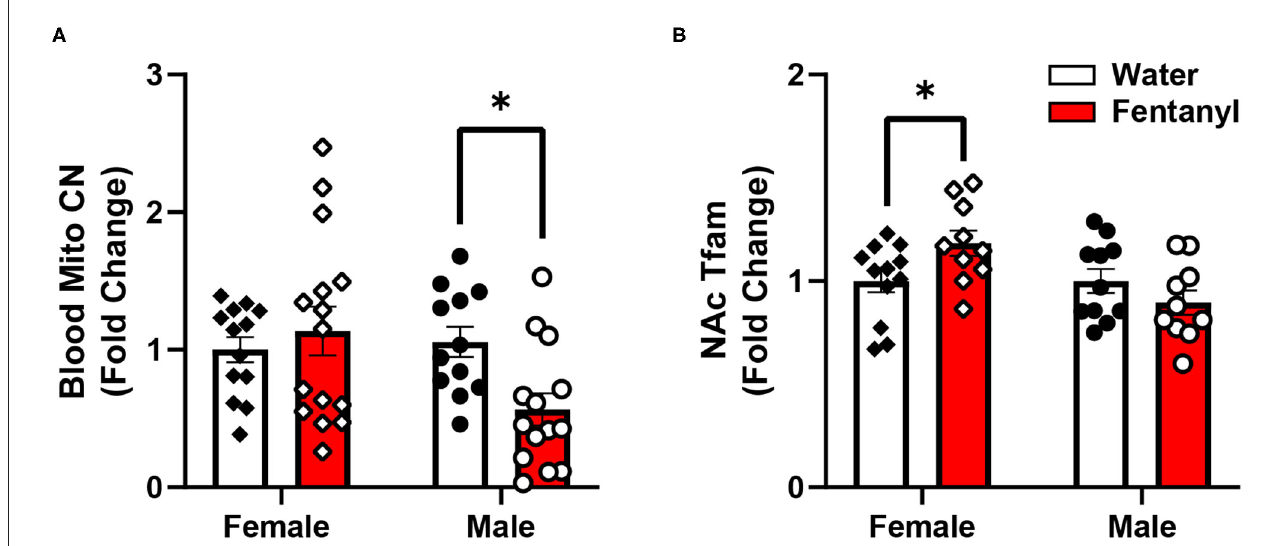
FIGURE 1 | Mitochondrial copy number in blood and gene expression in NAc after developmental fentanyl exposure. (A) Developmental fentanyl decreases blood mitochondrial copy number in male, but not female adolescent mice. (B) Developmental fentanyl increases mRNA expression of Tfam in NAc in female, but not male mice. * p <